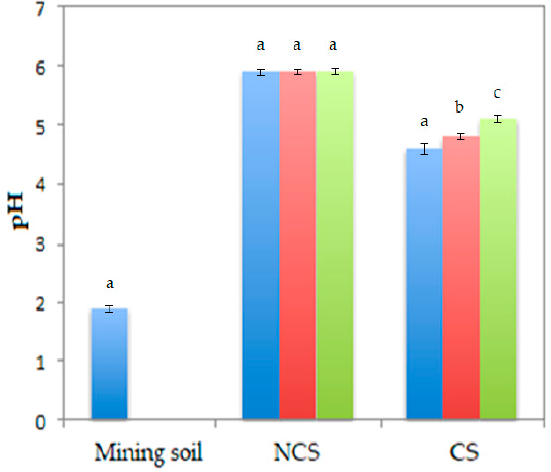
Figure 1. pH of the mining soil, NCS and CS at days 0 (blue bars), 30 (red bars) and 90 (green bars). Different letters in the same soil indicate significant differences in the pH value according to Duncan’s multiple range test ( p ≤ 0.05).